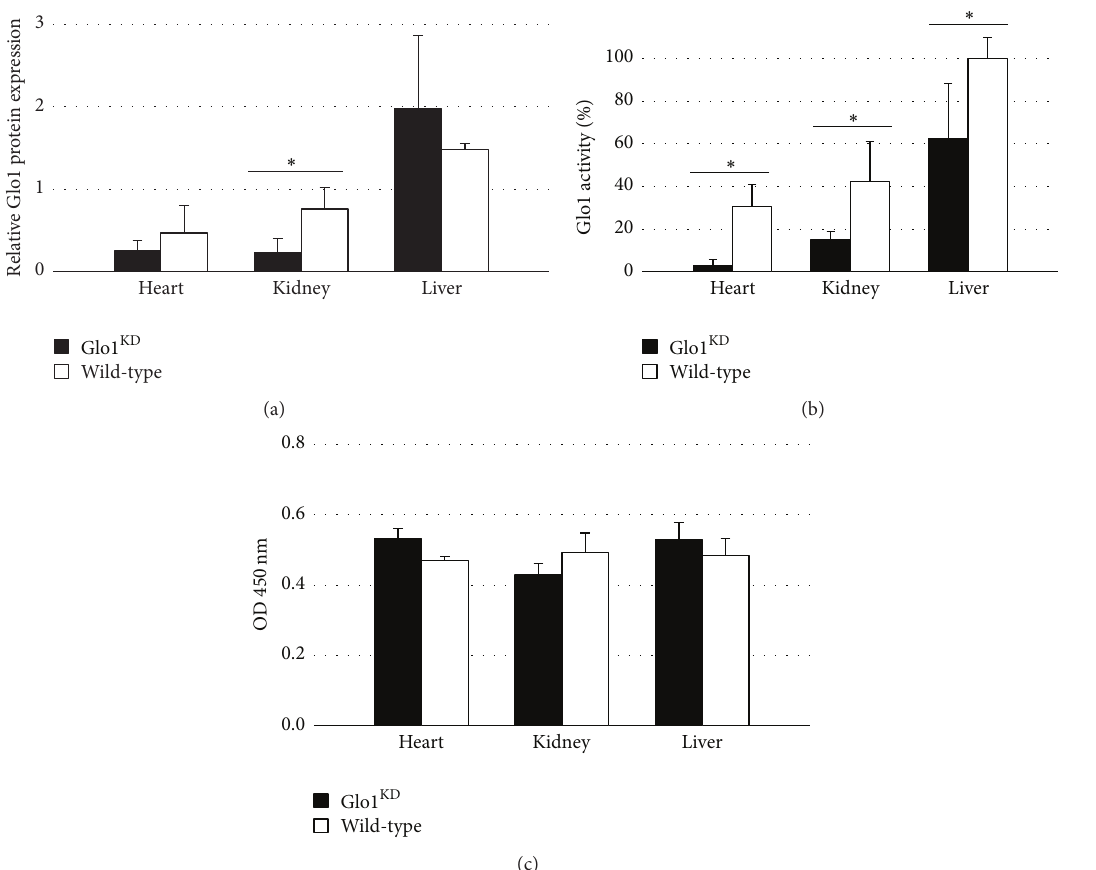
Figure 1: (a) Glo1 protein levels measured via Western blot were significantly reduced in the kidney ( 𝑝 = 0.0096 ), whereas protein levels in the heart ( 𝑝 = 0.27 ) and the liver ( 𝑝 = 0.34 ) did not differ significantly. (b) Glo1 activity was significantly reduced in the heart ( 𝑝 = 0.001 ), kidney ( 𝑝 = 0.03 ), and liver ( 𝑝 = 0.03 ) of Glo1 KD mice in comparison to wild-type animals ( 𝑛 = 4 ). Glo1 activity in the liver of wild-type mice was arbitrarily set to 100%. (c) The levels of methylglyoxal-derived AGEs were measured via an ELISA. There was no significant